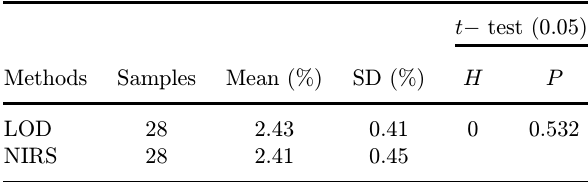
Table 4. The results of paired t -test.